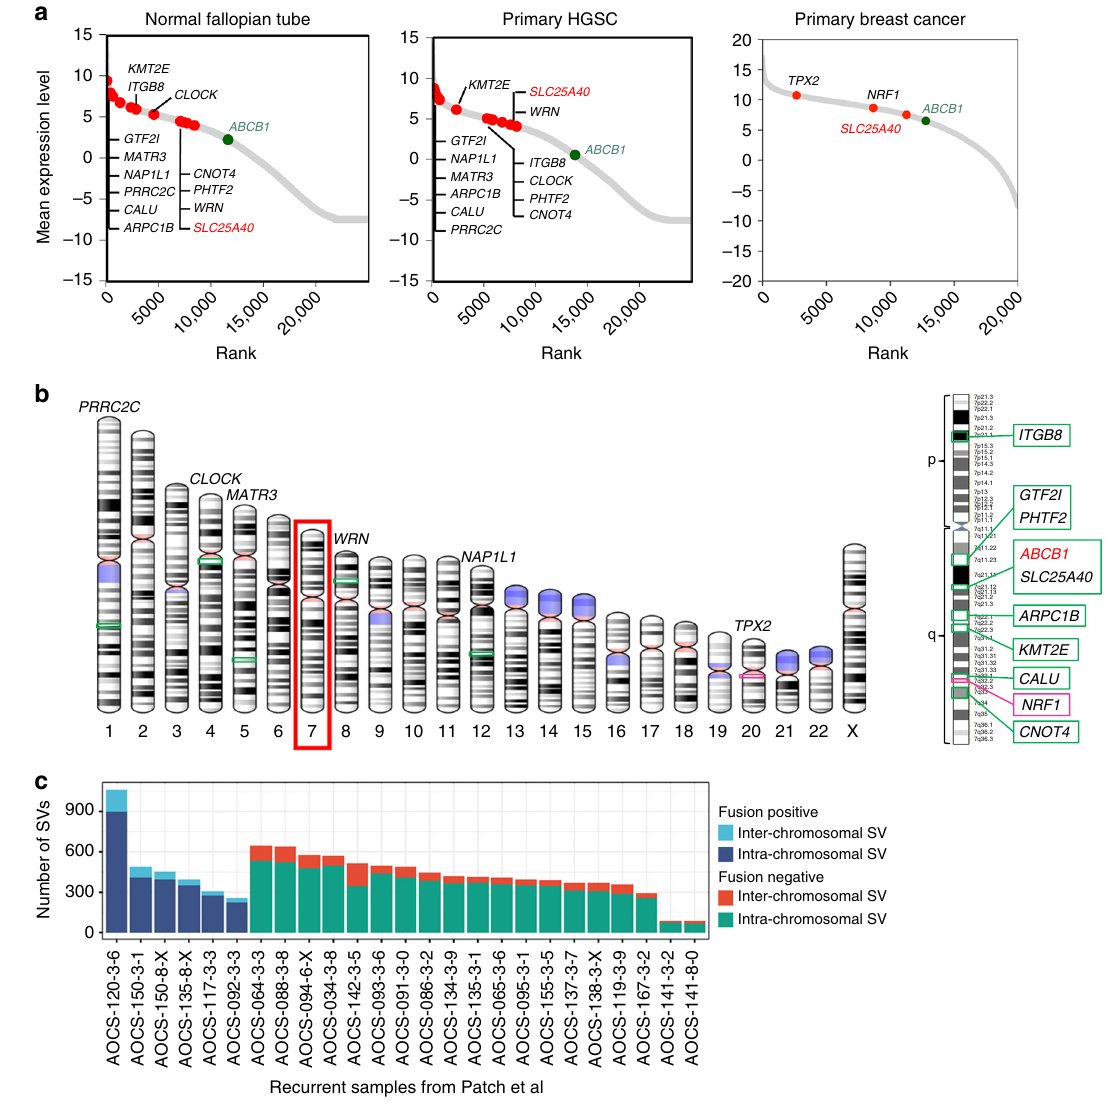
Fig. 2 Characteristics of fusion partners. a Mean expression of all genes from normal fallopian tube, primary HGSC and primary breast cancer RNAseq data. Gene expression was rank ordered. Fusion partners are highlighted in red, ABCB1 in green. b Chromosomal location of fusion partners, with a majority located on chromosome 7 (boxed). c Number of SVs, by type, in recurrent HGSC samples described as ABCB1 fusion-positive or